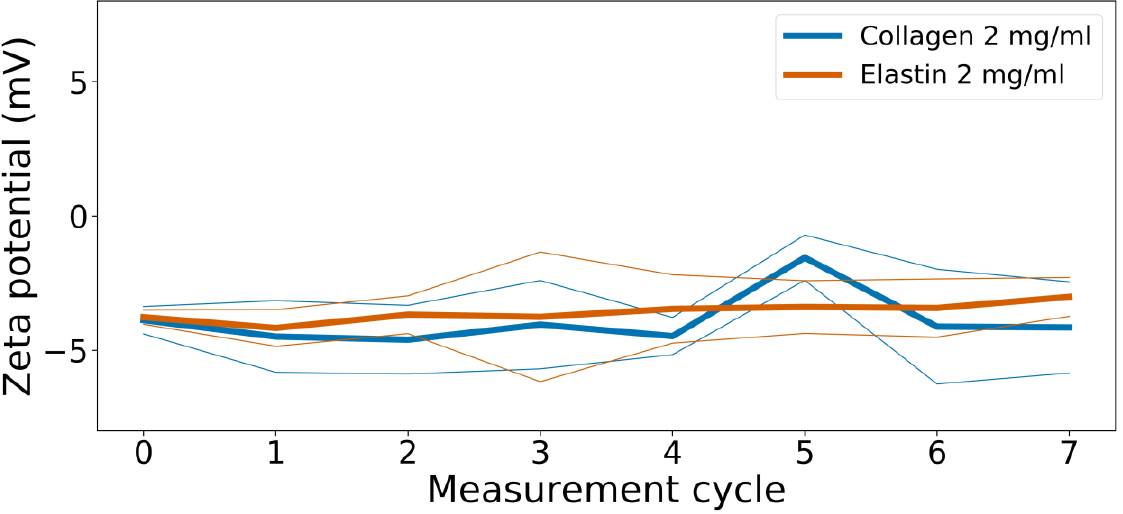
Figure 2. Zeta size measurements of a collagen (2 mg/mL) and an elastin solution (2 mg/mL) in a phosphate buffer at pH 7.5 and 4 °C. Incremented mean (thick lines) and one standard deviation (thin lines) are shown. As data points along the curves have slightly varying total run times from 7 to 10 min (due to variations in temperature regulation by the device), the data points were averaged accordingly and plotted over the increment. Original data can be found in supporting Figure S4.